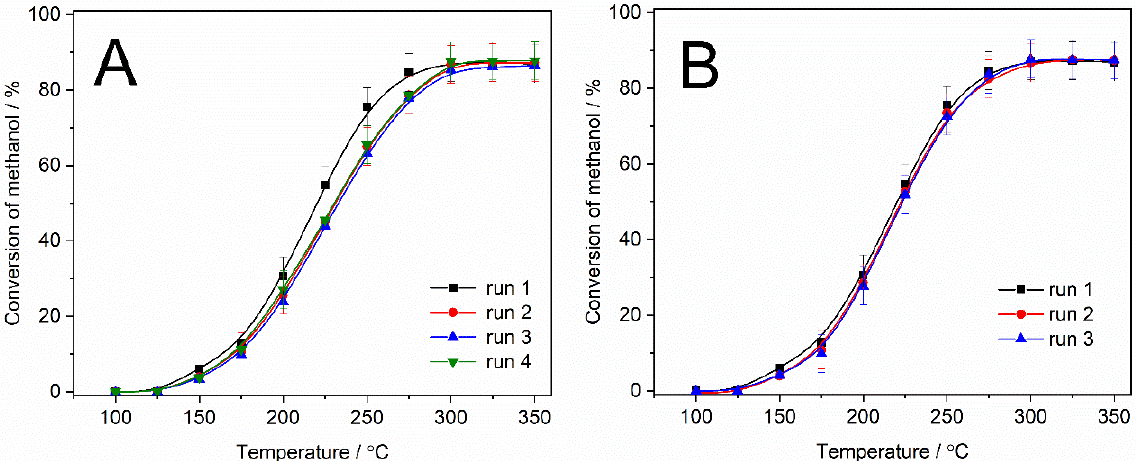
Figure 6. Results of the subsequent catalytic tests in the reaction of methanol to DME dehydration in the presence of the 3Al-TIE catalyst: ( A ) runs without catalyst regeneration, ( B ) runs with catalyst regeneration.